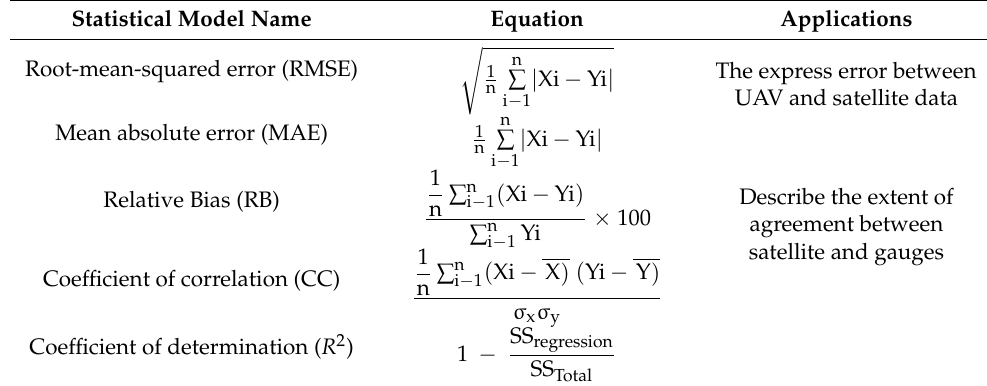
Table 5. Statistical measures.